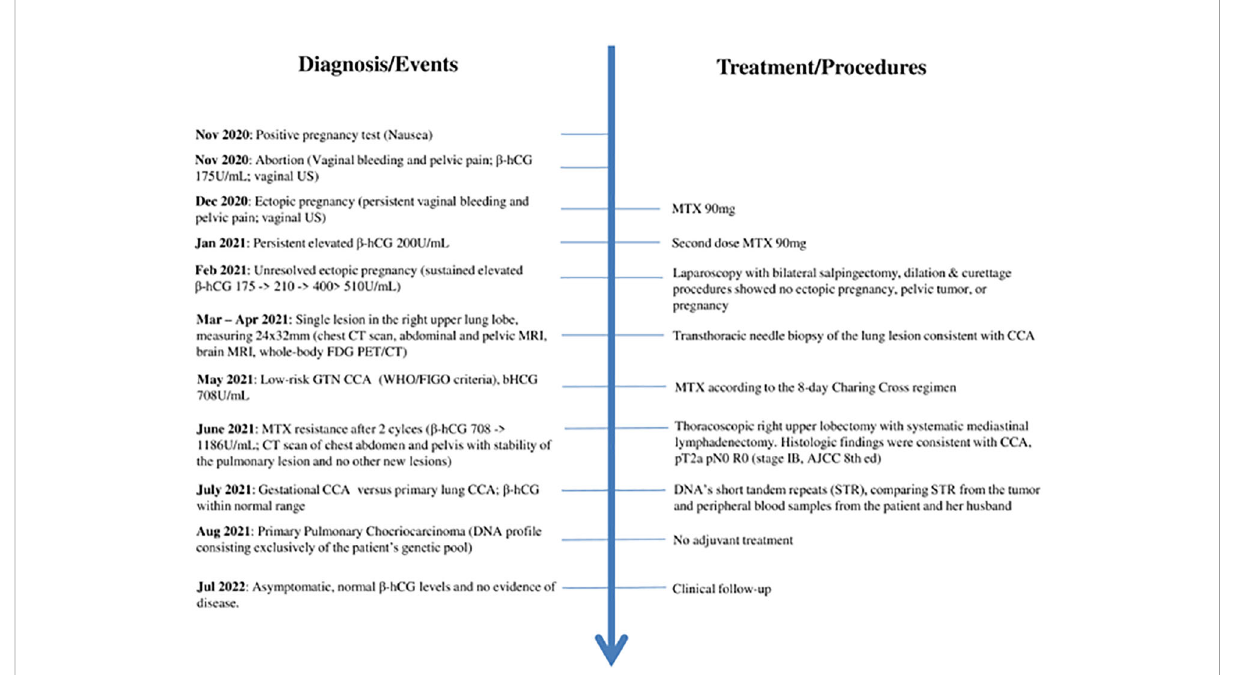
FIGURE 3 Timeline with relevant data from the episode of care. US – Ultrasound; MTX – methotrexate; GTN - Gestational trophoblastic neoplasia; CCA -